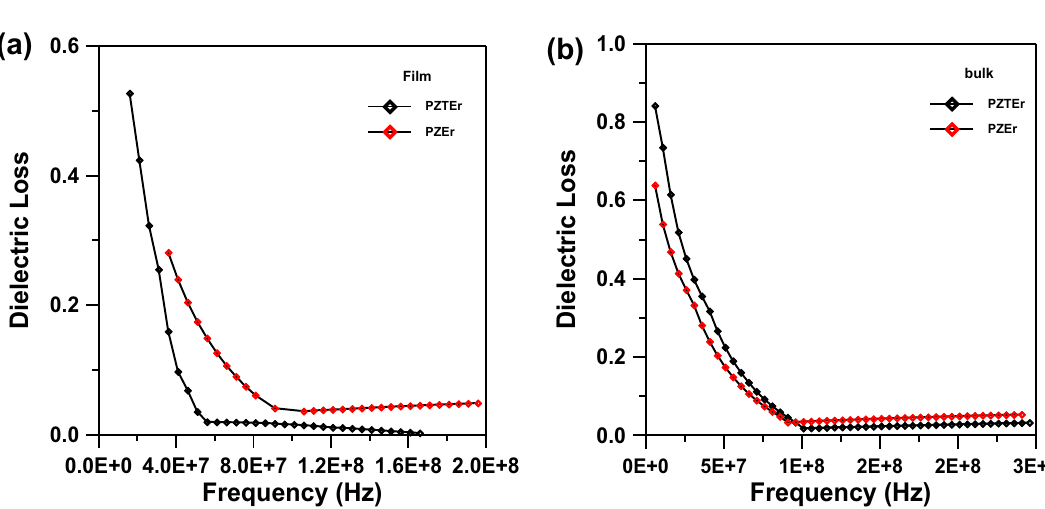
Figure 7. ( a ) Dielectric loss versus frequency for Er-doped PEZ and PEZT thin film samples. ( b ) Dielectric loss versus frequency for Er-doped PEZ and PEZT bulk